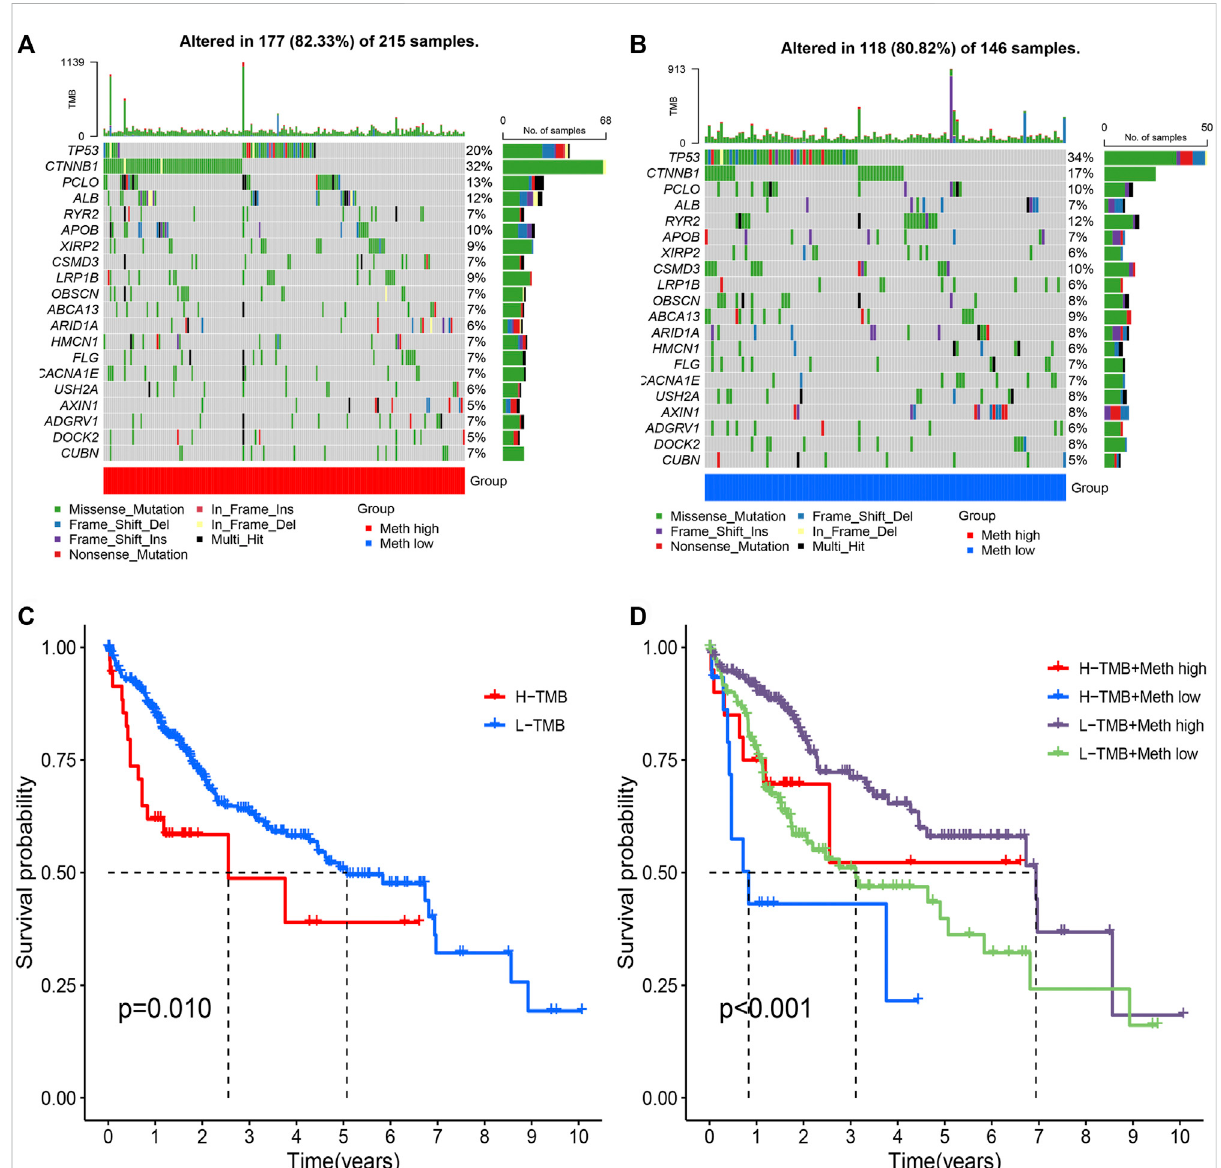
FIGURE 5 Tumor mutation analysis in two subtypes. (A) The mutation waterfall map of Cluster 1 group (Meth high). (B) The mutation waterfall map of Cluster 2 group (Meth low). (C) Survival analysis of two groups. (D) Survival analysis of four groups.